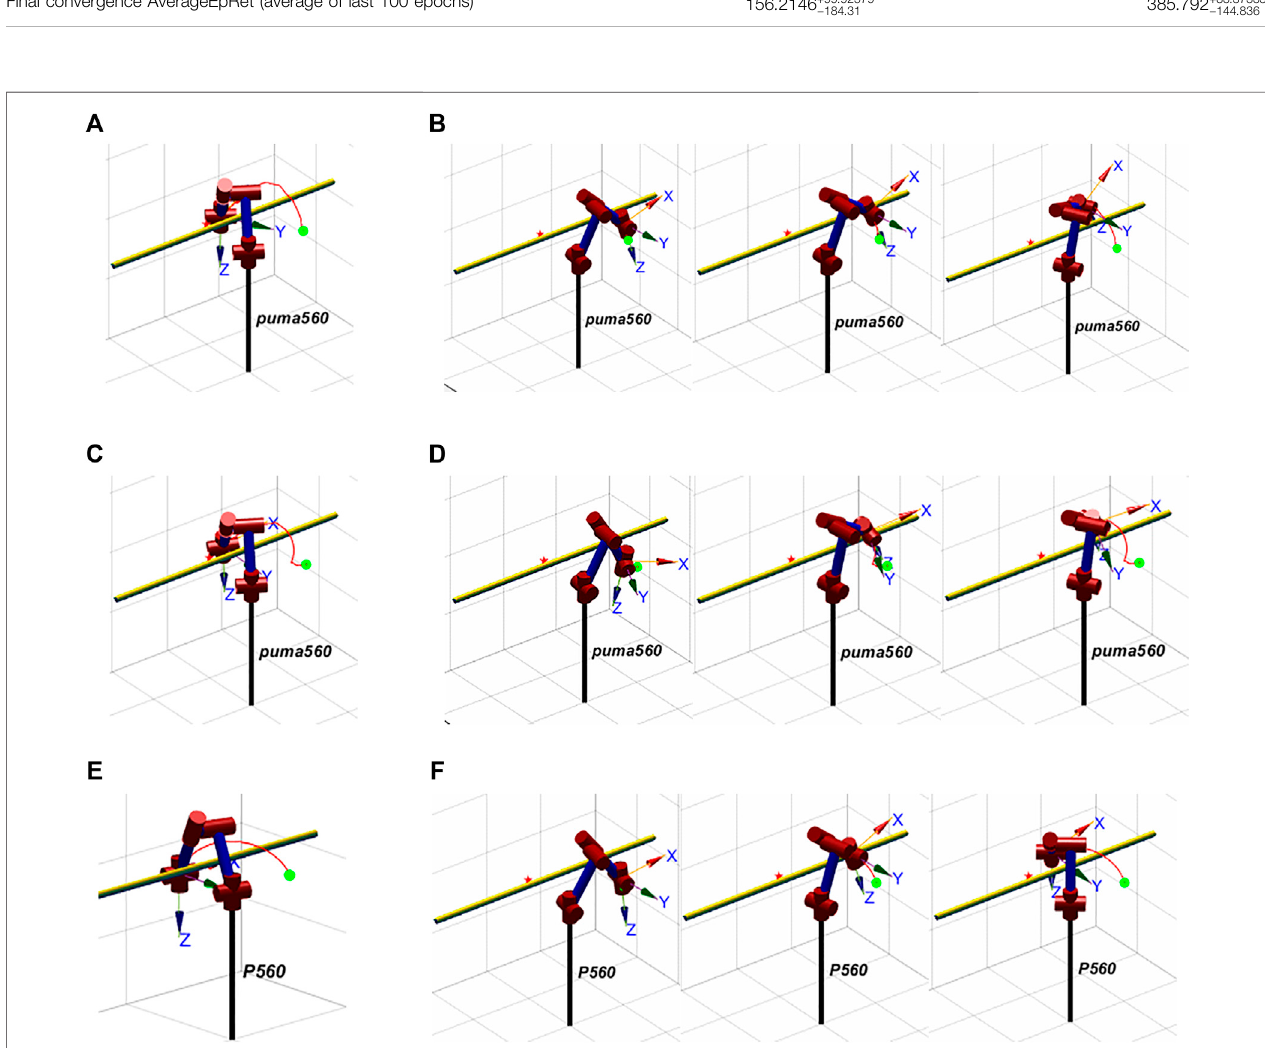
FIGURE8| Processofmanipulator ’ smotion. (A) CompletemotiontrajectoryofD-SAC. (B) ObstacleavoidanceprocessofD-SAC. (C) Completemotiontrajectory of P-SAC. (D) Obstacle avoidance process of P-SAC. (E) Complete motion trajectory of PSO. (F) Obstacle avoidance process of PSO.